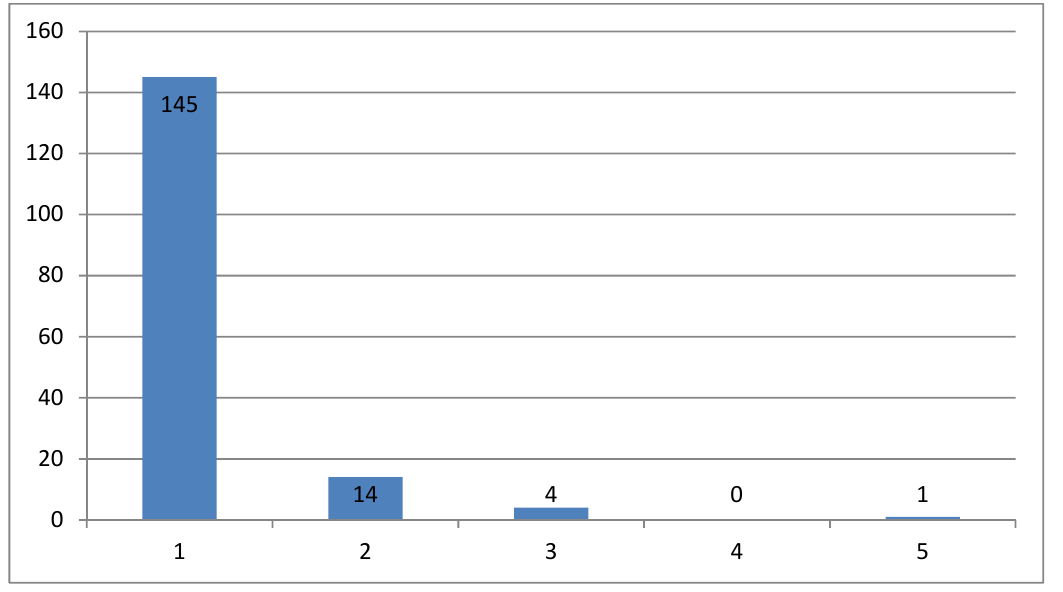
Fig. 3. ATMs Daily Cash Strategies